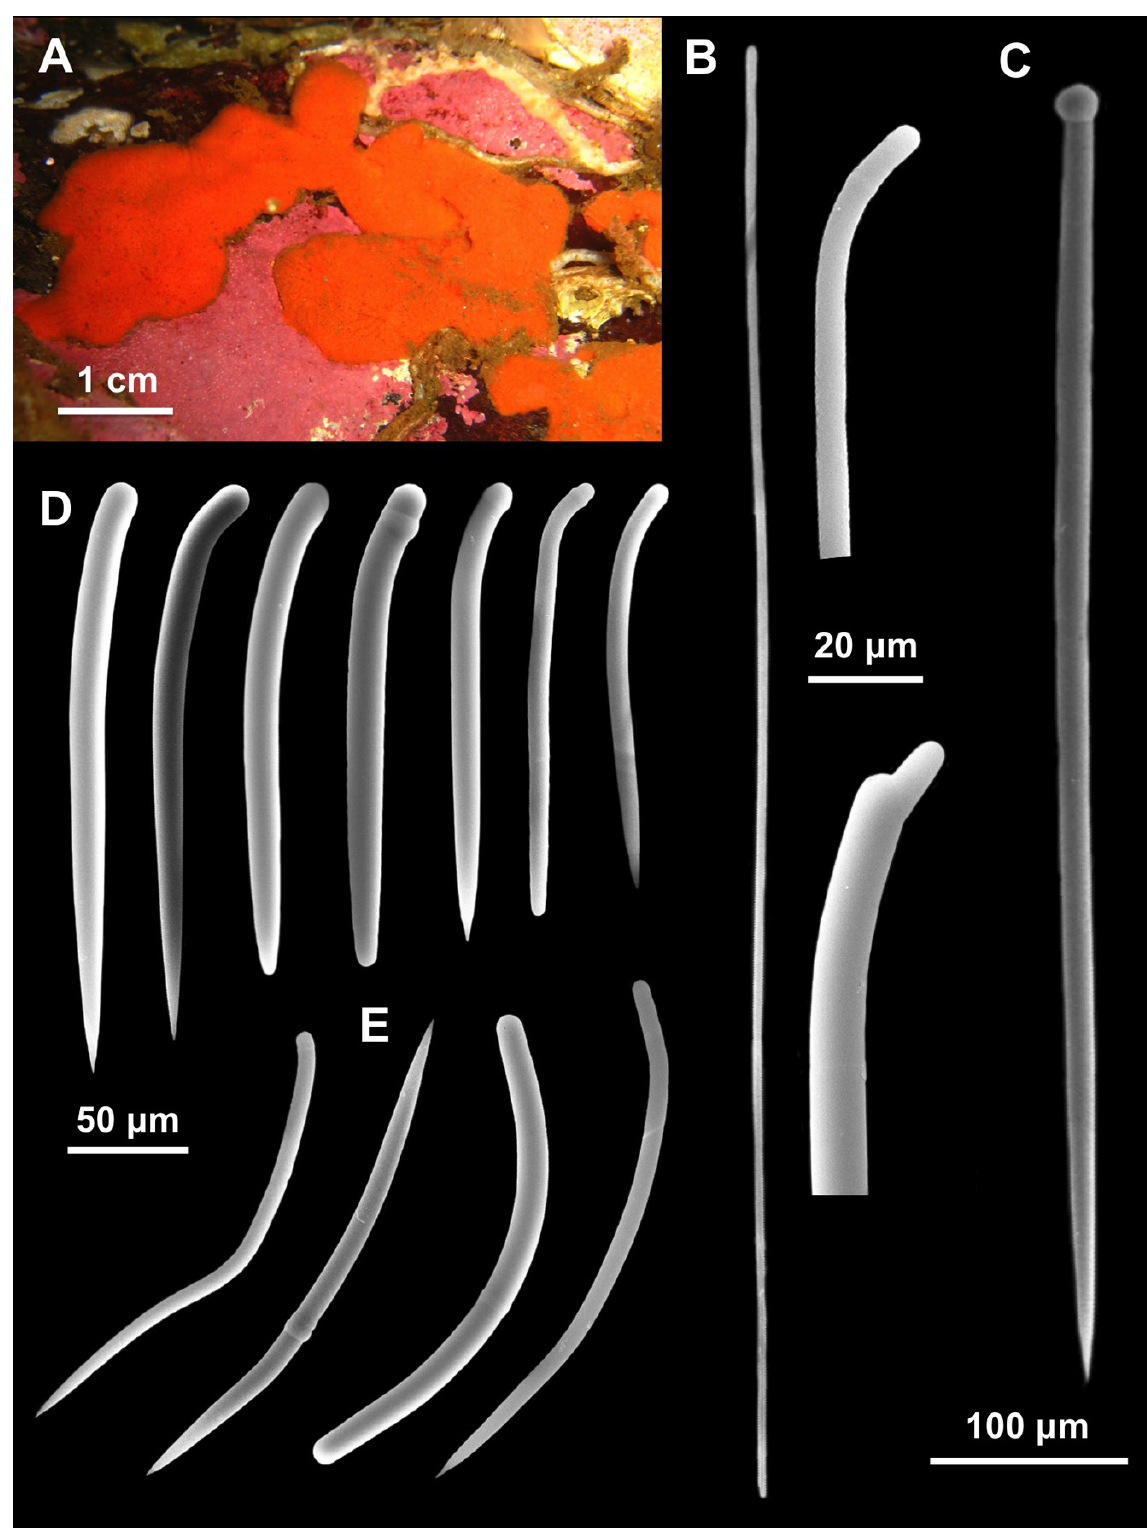
Fig. 2. Hymerhabdia imperfecta Bertolino, Costa & Pansini sp. nov., holotype (CILE 63; MSGN 60889). A . The holotype in life. B . Smooth styles. C . Smooth thicker tylostyles. D . Rhabdostyles. E . Rhabdostyles are often sinuous or modified in oxeas or